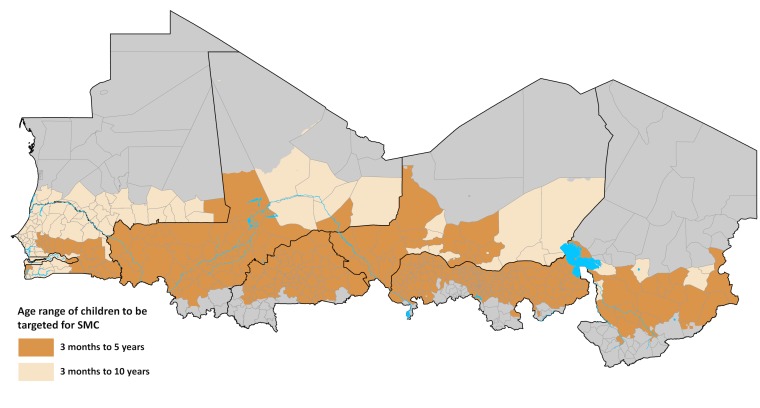
Map of the Sahel showing the health districts that are not suitable for SMC targeting (grey n = 119) and SMC suitable health districts (light to dark brown, n = 478) classified by age class of target children.The SMC suitable districts were those where PAPfPR2-10 in 2000 was ≥5% and 80% of the population lived in areas where ≥60% or more of the annual total rainfall occurs in any three consecutive months. In SMC health districts where PAPfPR2-10 in 2010 was ≥5% to 10% (n = 123) children 3 months to <10 years of age were targeted for SMC while those where it was >10% (n = 355) children 3 months to <5 years of age were targeted. *All inputs are either generated at or resampled to surfaces of 1 x 1 km spatial resolutions. A) Monthly Africa Rainfall Estimates version 2 (RFE 2.0) data from 2002–2009 at 10 × 10 km spatial resolution [NOAA 2013] were used to generate average long term monthly rainfall which are then used to define average seasonality (Section D in S1 File); B) Maps of total population are disaggregated by age structure (3 months to below 5 years; 5 years to below 10 years) using data from census and household surveys and by urban and rural using population density, night time lights and other land cover classifications (Section C in S1 File). Countries should use most recent census and survey data for population projections and age categorisations; C) For all countries except Niger and Mauritania PfPR2-10 data from the period 1980–2012 were used to estimate endemicity from 2000 and 2010 (Section F in S1 File). D) A map based on the presumed relationship between P. falciparum transmission, temperature and rainfall to define the length of transmission seasons was downloaded as a grid surface from International Research Institute for Climate and Society website [IRI URL]. The map was at spatial resolution of approximately 50 x 50 km and was resampled to 1 x 1 km (Section E in S1 File); E) The approach by Cairns et al (2012) that identified acute malaria seasonality as areas where 60% or more of the annual total rainfall occurred in three consecutive months was used. This approach had a high sensitivity (95%) of areas where over 60% of malaria cases occurred in 4 consecutive months (Section D in S1 File,); F) Data from a variety of international and national sources were used to develop the most recent boundaries of health districts (Section B in S1 File). Due to population growth and changes in governance health districts change frequently and countries should continuously update these boundary changes. G-J) Health districts where ≥80% of population lived in areas of acute malaria seasonality and had 2000 PAPfPR2-10 ≥ 5% were considered suitable for SMC (Section F in S1 File). This endemicity threshold allowed for the inclusion of areas where current risk is low but where receptive risk is still high. Population estimates by age class, urban and rural were extracted to each health district (S1 File); K) In districts where 2010 PfPR2-10 was 5% to ≤10%, children aged 3 months to <10 years were targeted for SMC and 3 to months to <5 years in higher transmission districts (Section F in S1 File). Countries can update the contemporary description of risk using most recent survey data. A decision also needs to be made on whether or not to include urban areas. L) The median number of transmission months was extracted for each health district from the climate based map of length of transmission (Section E in S1 File) and was multiplied by the estimated number of SMC targeted children and the 1 SP and 3 AQ tablets per child per month (Section F in S1 File).